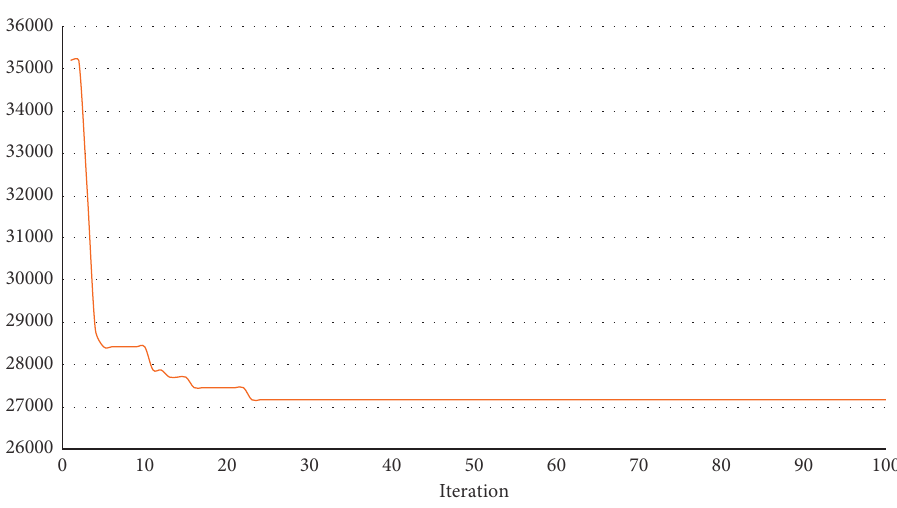
Figure 5: Convergence characteristics at 315MW generation and 328.4MW